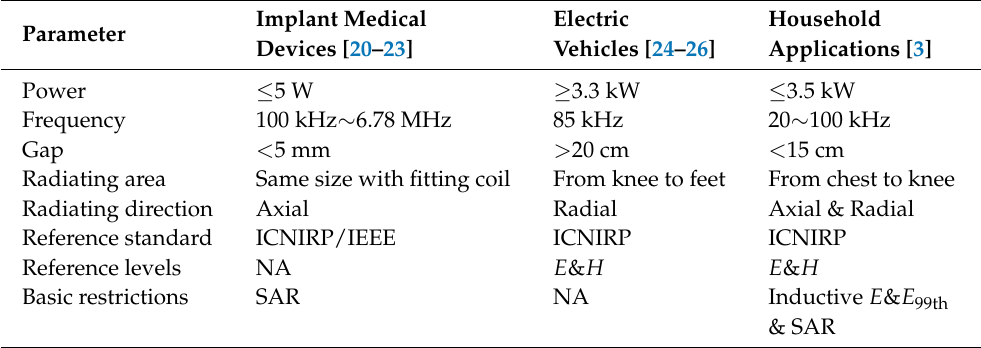
Figure 1. Comparison of ( a ) H -field strength and ( b ) E -field strength of various safety standards. Table 1. Comparison of operating standards for various IPT applications.